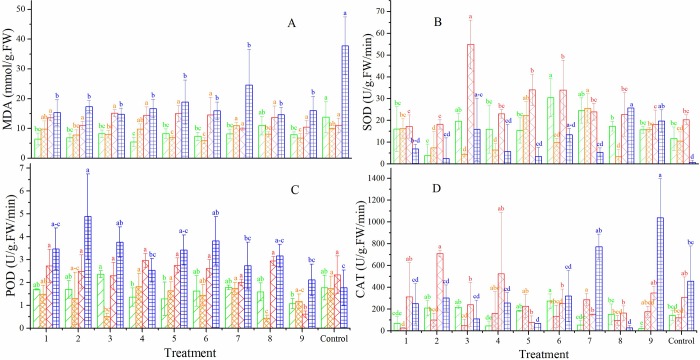
MDA content (A), activity of SOD (B), POD (C) and CAT (D) of tall fescue (2015 and 2014), orchardgrass (2013) and Russian wildrye (2009). Data are presented as mean ± SD. The different lowercase letters indicate significant differences at P < 0.05 within the years among the treatments.